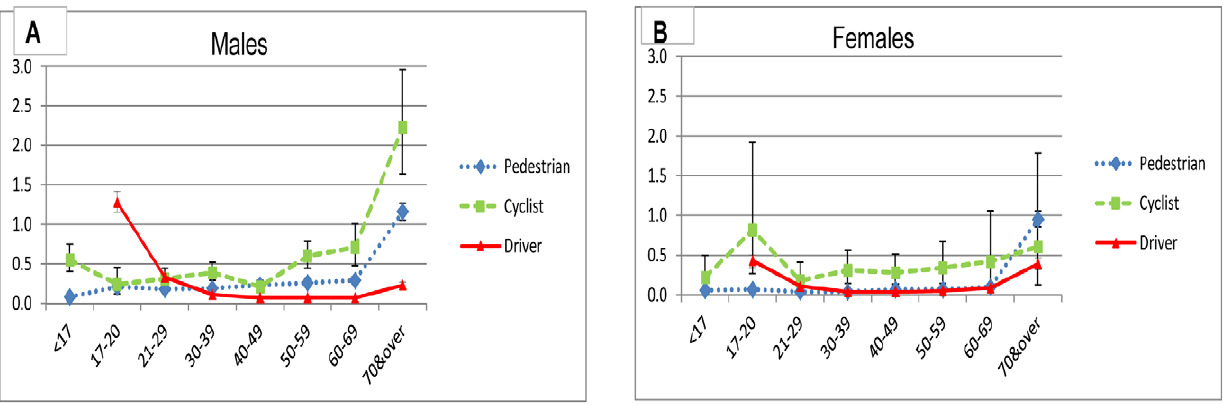
Figure 2. Fatality rates per million hours’ use by travel mode, age, and sex. a. Males. b. Females. f/mhu: fatality rate per million hours use in England, 2007–2009. doi:10.1371/journal.pone.0050606.g002 PLOS ONE |